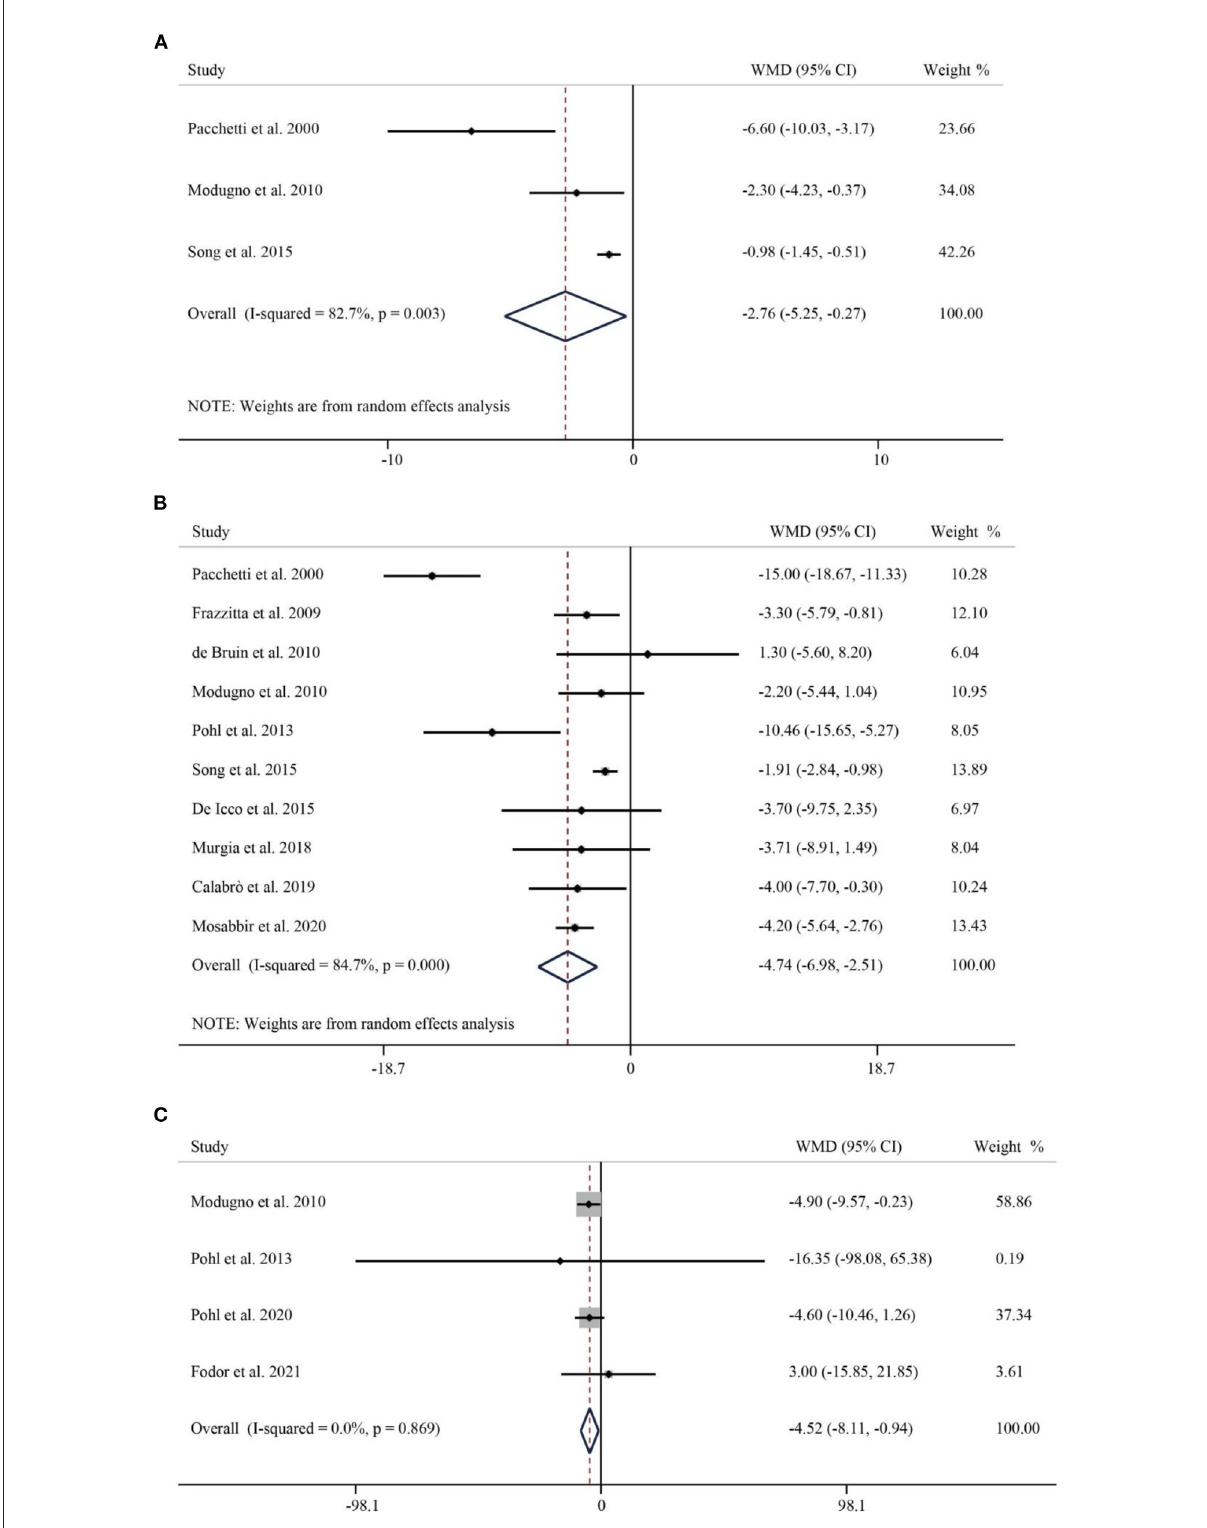
FIGURE5 Forest plot of RAS vs. the control group for UPDRS-II (A) , UPDRS-III (B) , and PDQL (C). UPDRS, Unified Parkinson’s Disease Rating Scale; UPDRS-II, UPDRS- Activities of Daily Living; UPDRS-III, UPDRS- Motor Symptoms; PDQL, Parkinson’s Disease Quality of Life